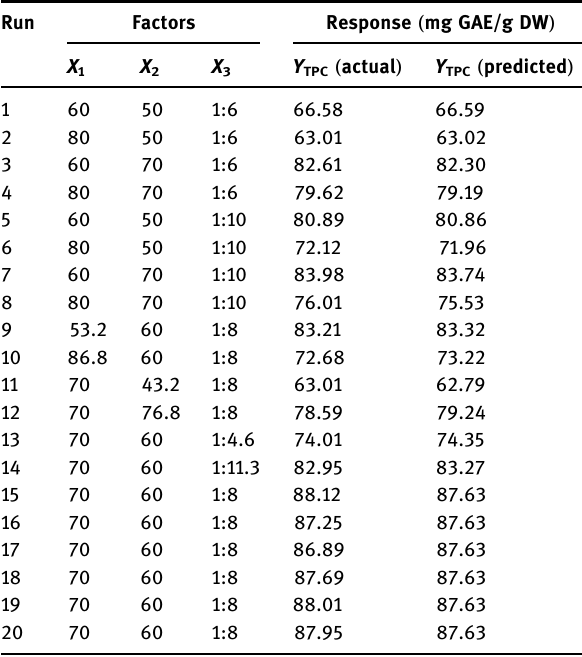
Table 2: CCD of actual factors and responses based on actual and predicted